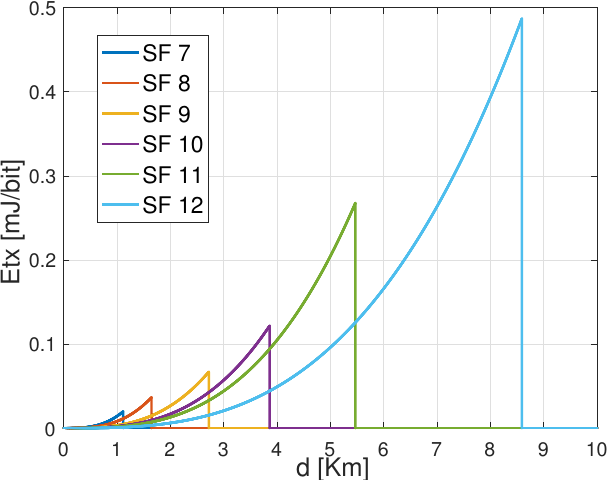
Figure 6. The transmission power performance relative to the range in Km carrying out a PL = 30 Bytes using setting of different SFs with CR 4/7.